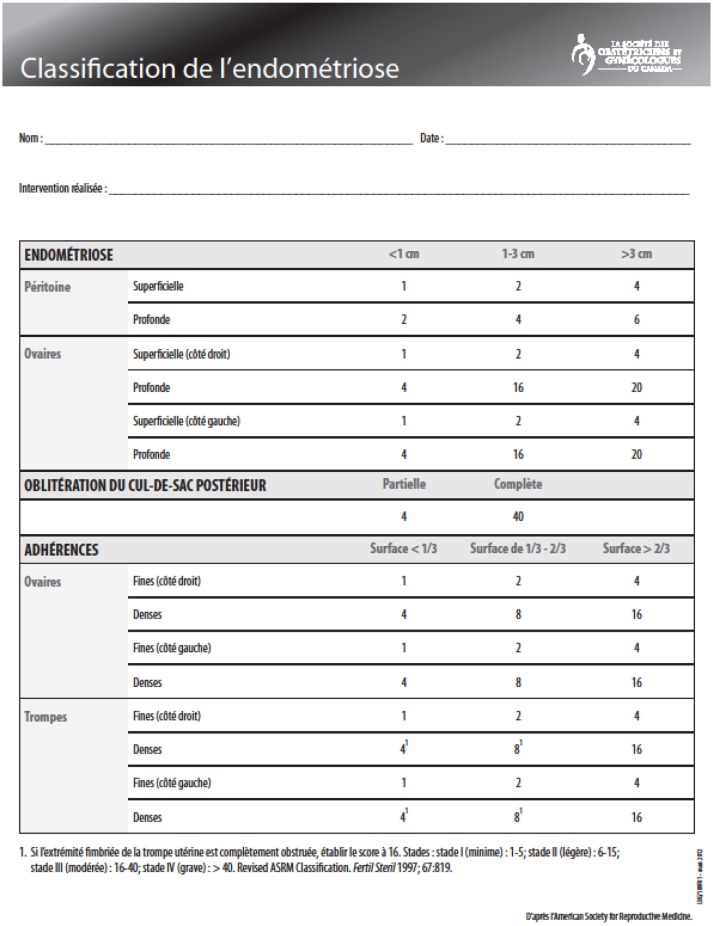
ASRM classification.